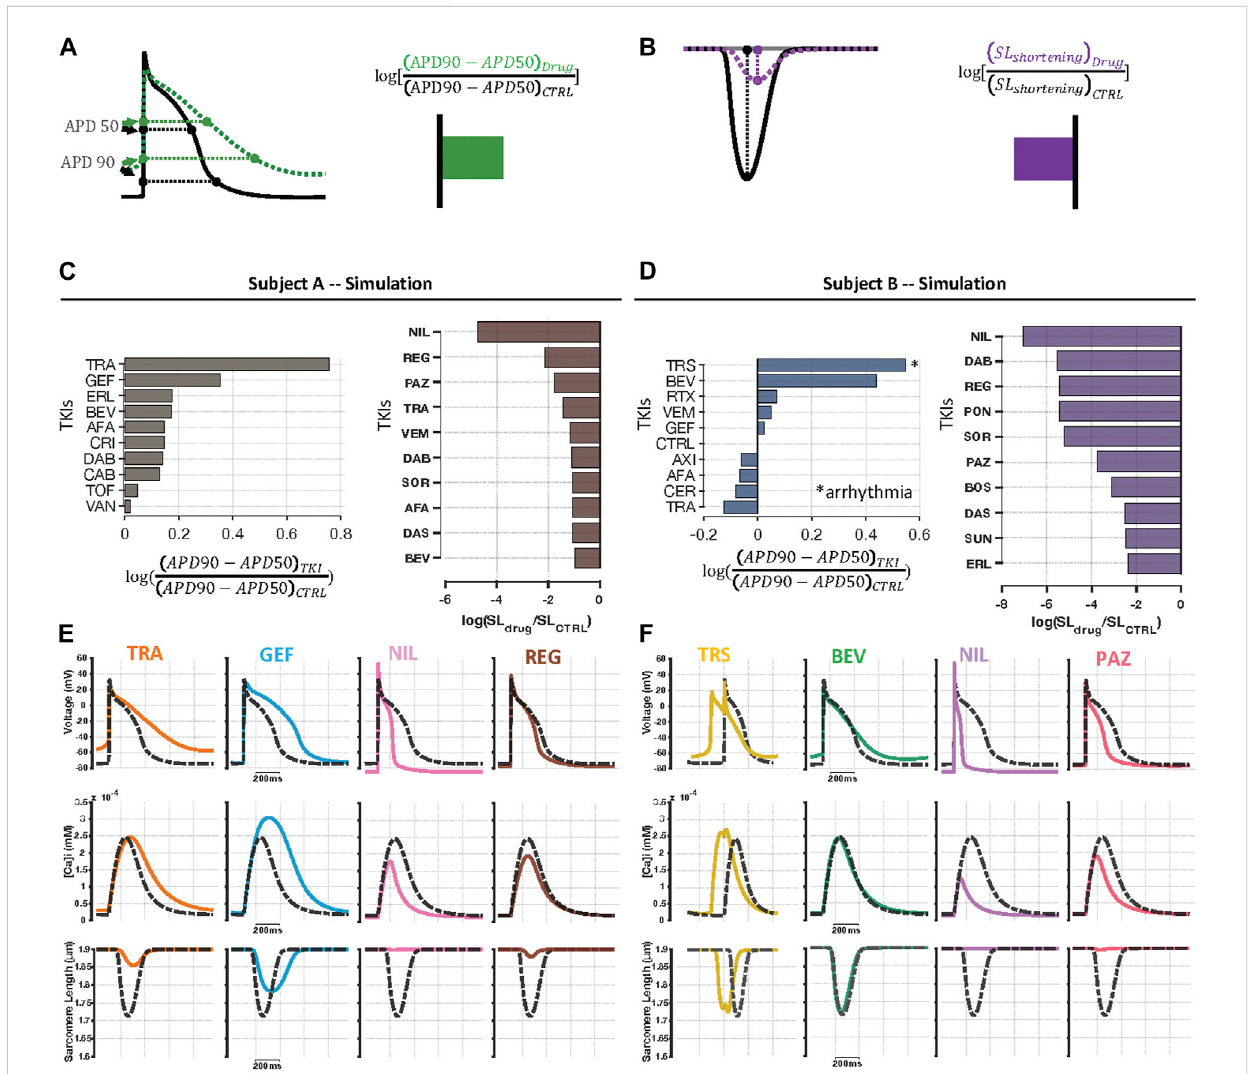
FIGURE 2 Individual speci fi c predictions of physiological alterations caused by TKIs. (A) To examine TKI-induced effects on electrophysiology, we computed triangulation of AP waveforms from the simulation output for each drug. In the diagram, the green curve, representing drug-induced changes, shows a moretriangularwaveformthantheblackcurve,representingthebaselinemodel,whichindicatesanincreaseintriangulation. (B) TKI-inducedcontractile dysfunction was evaluated using sarcomere length shortening simulation results. Because the drug-treated purple curve exhibits reduced shortening compared with the black (control) curve, this change is summarized as a decrease in contraction strength. (C, D) Individual speci fi c, top 10 rankings for log-transformed AP triangulation and contractile failure metrics. Amongst the top 10 most highly-ranked TKIs, there was higher level of correlationbetweensubjectAandBincontractiledysfunction(Spearman ’ srankcorrelation, ρ =0.64, p =0.054)thanAPtriangulationrankings( ρ =-0.16, p = 0.65). (E, F) Example AP, CaT, and SL shortening simulation results in the two cell lines showing examples of drug-induced AP triangulation and contractile failure. Dashed black curves represent untreated cells, and colored lines represent predictions for, from left to right, trametinib, ge fi tinib, nilotinib, and regorafenib in Cell Line A, and trastuzumab, bevacizumab, nilotinib, and pazopanib in Cell Line